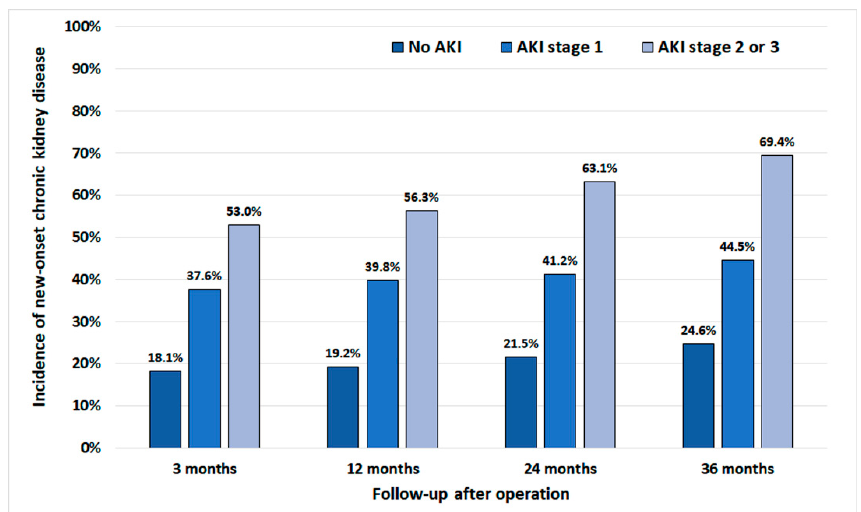
Figure 2. Comparison of the cumulative incidence of chronic kidney disease (estimated glomerular filtration rate (eGFR) <60 mL/min/1.73 m 2 ) at follow-up time points between the patients without acute kidney injury (AKI), those with stage 1 AKI, and those with stage 2 or 3 AKI. There were significant differences in the incidence of chronic kidney disease at all time-points.